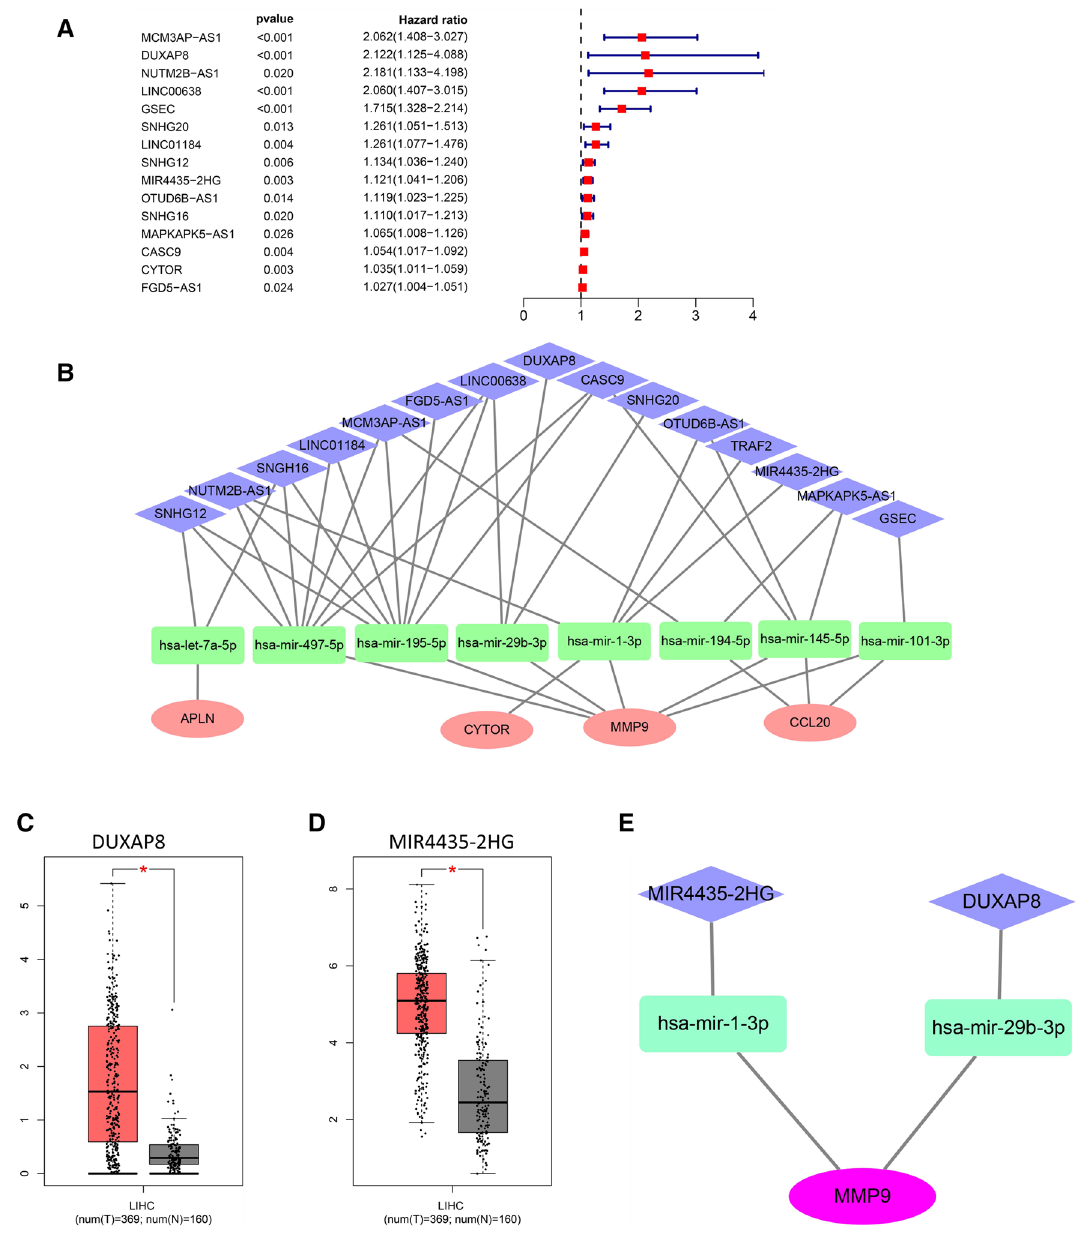
Fig. 4 Identification of upstream lncRNAs of miRNAs and the construction of ceRNA network. a Screening of 15 lncRNAs related to a poor prognosis in liver cancer patients. b Construction of corresponding ceRNA networks based on these 15 lncRNAs. DUXAP8 ( c ) and MIR4435- 2HG ( d ) were highly expressed in HCC. e The ceRNA MIR4435-2HG/hsa-miR-1-3p/MMP9/hsa-miR-29-3p/DUXAP8 network